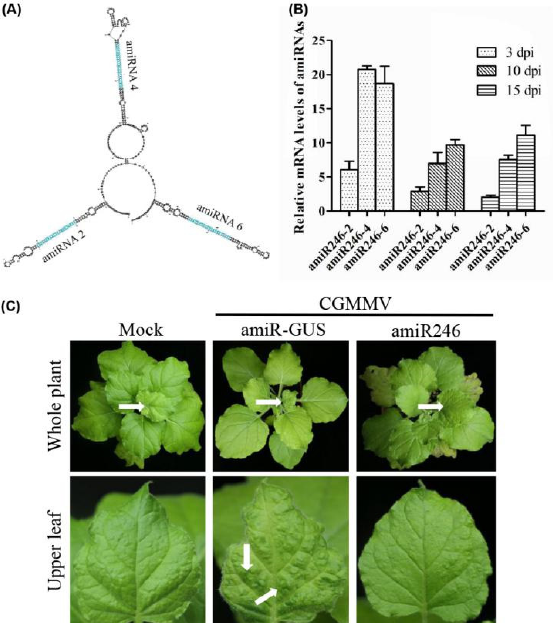
Figure 5. Biological activity of the polycistronic amiR246 to CGMMV in Nicotiana benthamiana transient assays. ( A ) Predicted secondary structure of polycistronic amiRNA (amiR246) via mFold analysis. ( B ) Expression levels of three amiRNAs in the polycistronic structure at 3, 10, and 15 dpi after inoculating with CGMMV in N. benthamiana plants. For each amiRNA, three biological replicates were evaluated using quantitative reverse transcription ‐ polymerase chain reaction, and three technical replicates were performed for each sample. Error bars represent the mean of three biological replicates ± standard deviation (SD). ( C ) Photographs of the upper leaves and whole plants were taken at 20 dpi. Characteristic symptoms of CGMMV ‐ induced mild leaf mottle and mosaic are indicated with white arrows. White arrows on whole plants indicate the upper leaves.